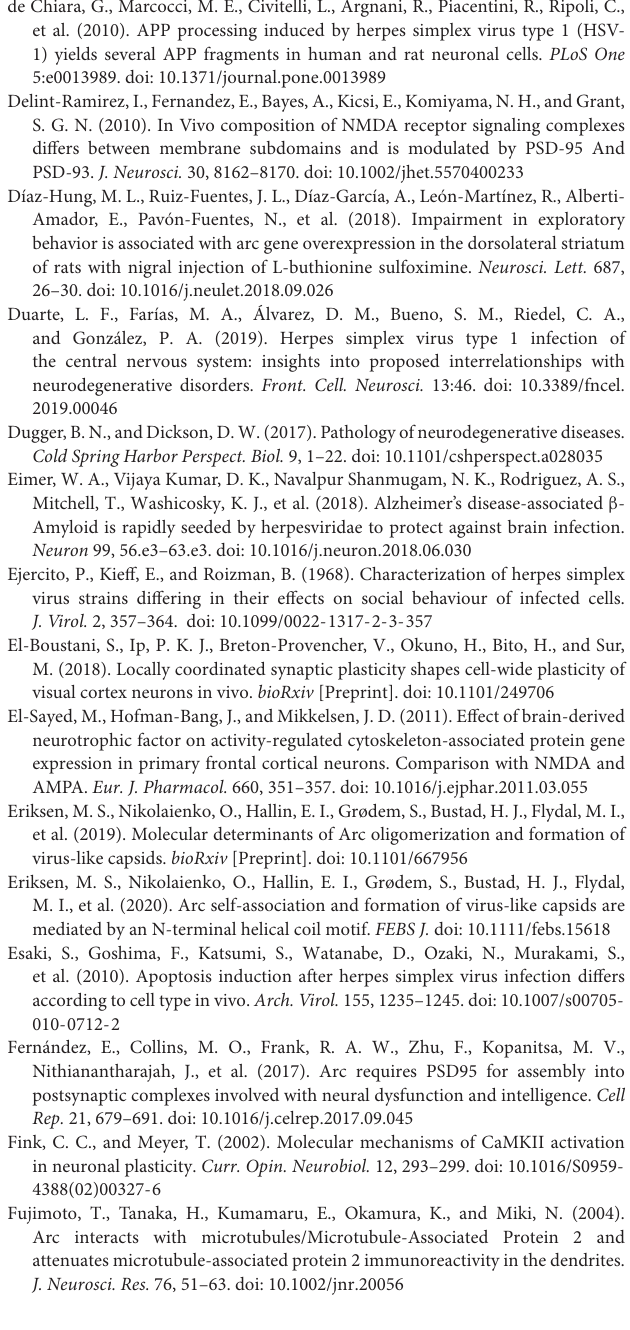
analyses of total protein extracts show an increase in phosphorylation of CREB at S133 residue, starting from 1 hpi compared with mock-infected cells. (B) Immunohistochemistry analyses of mock-infected and 4 hpi cells, stained against phospho-S133-CREB (green), ICP8 (red), and DAPI for nuclei (blue). (C) CREB mRNA relative expression levels at Mock, 4 and 8 hpi. Supplementary Figure 3 | Arc and HSV-1 TK genes share common transcriptional regulatory elements. In silico analyses of Arc (A) and UL23 (B) gene promoter show the presence of C CAAT-box (C) , GC-box (D) , and TATA-box (E) consensus sequences. The location of every site is depicted regarding the transcription start site